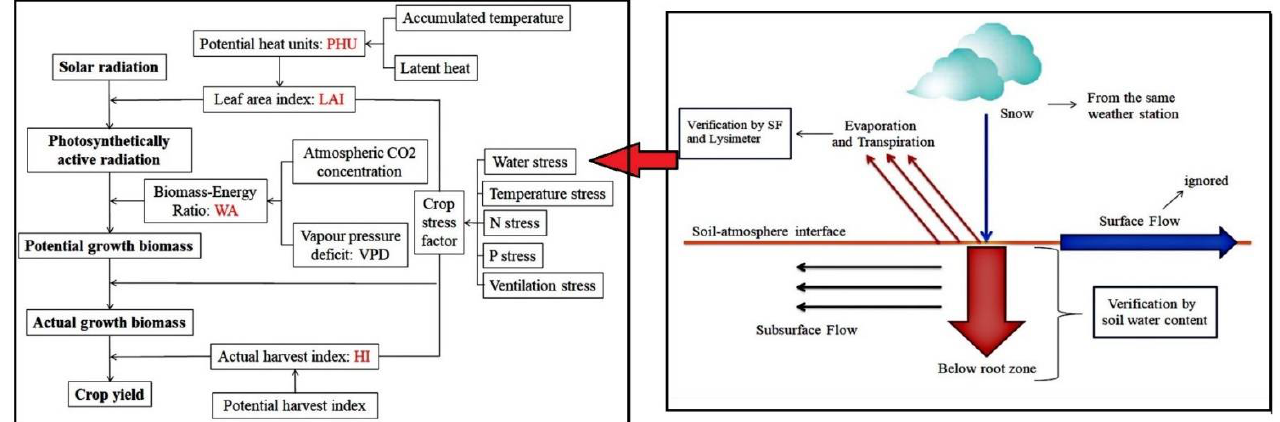
Figure 2. Calculation process of crop growth and hydrology cycle in EPIC model. Table 2. Related parameters of crop and hydrological cycle in EPIC